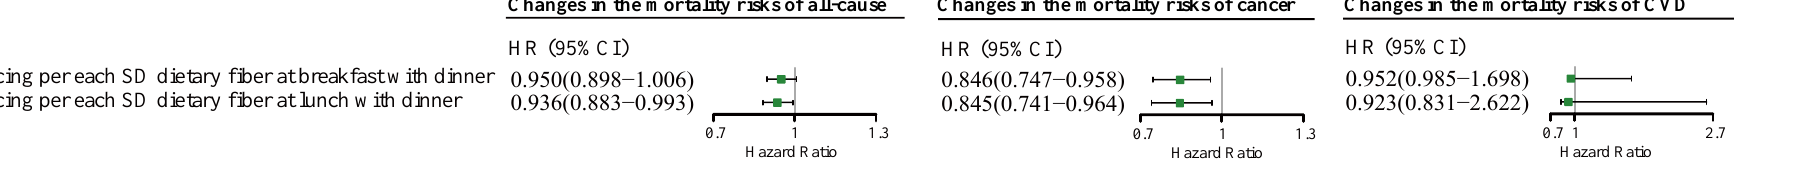
Figure 3. Multivariate adjusted HRs for all-cause, cancer, and CVD mortality: equivalent substitution of dietary fiber from breakfast and lunch to dinner. Adjusted covariates in model 3 are based on model 1 with additional adjustment of total dietary fiber intake(low/high), energy intake at breakfast, lunch, and dinner, and residual fiber intake at breakfast, lunch, and dinner. Covariates in model 1 include age (5 categories); sex; classification of BMI; ethnicity; income; education level; smoking and drinking status; regular exercise; nutrient supplement use; total intake of energy (10 categories); percentage of energy provided by protein, fat, and carbohydrates; AHEI (10 categories); the prevalence of diabetes, hypertension, and hyperlipidemia; and medication use for glucose or blood pressure or blood lipids. BMI, body mass index; AHEI, Alternative Healthy Eating Index; CVD, cardiovascular disease; Case/ n , number of case participants/total; Q, Quintile; HR, hazard ratio.